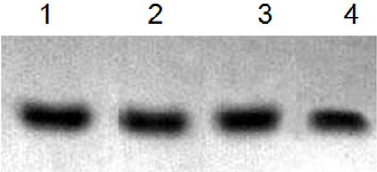
Figure 2. Gels stained with different staining solutions. BSA (500 ng) was separated by SDS-PAGE and stained with different acid- soluble CBBR at boiling temperature for 60 s. Added to the water- soluble CBBR staining solution were 0.3% HCl (Lane 1), 0.3% phosphoric acid (Lane 2), and 0.3% acetic acid (Lane 4), respectively.